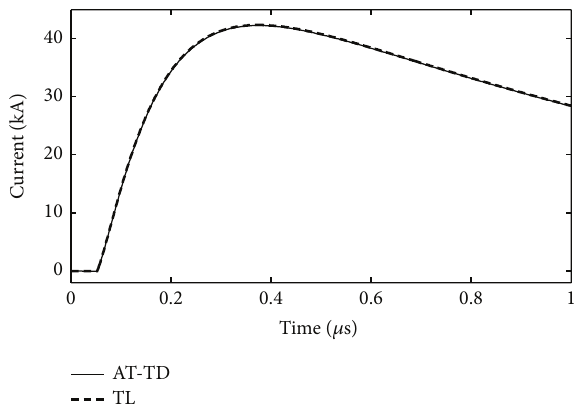
Figure 9: Transient current at the centre of the electrode: 𝐿 = 10 m, 𝜎 = 10 mS/m, and 0.1/1 𝜇 s pulse.